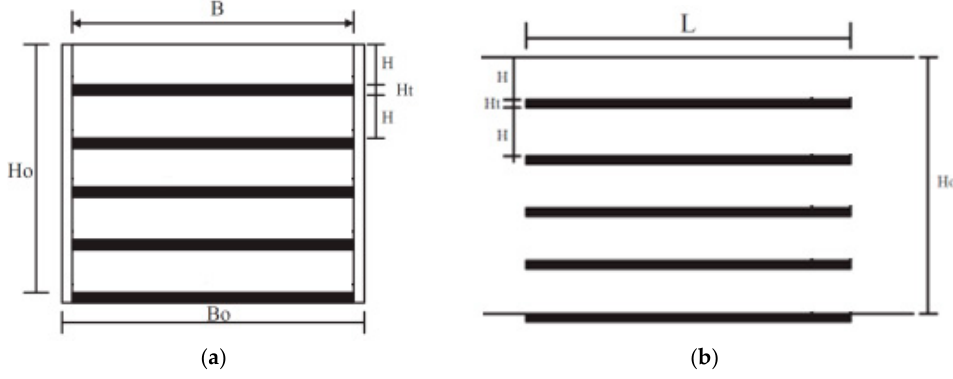
Figure 3. Schematic diagram of the investigated SPCD (symbol (cid:188) in Figure 2) (not to scale). ( a ) Front view; and ( b ) Sectional view.